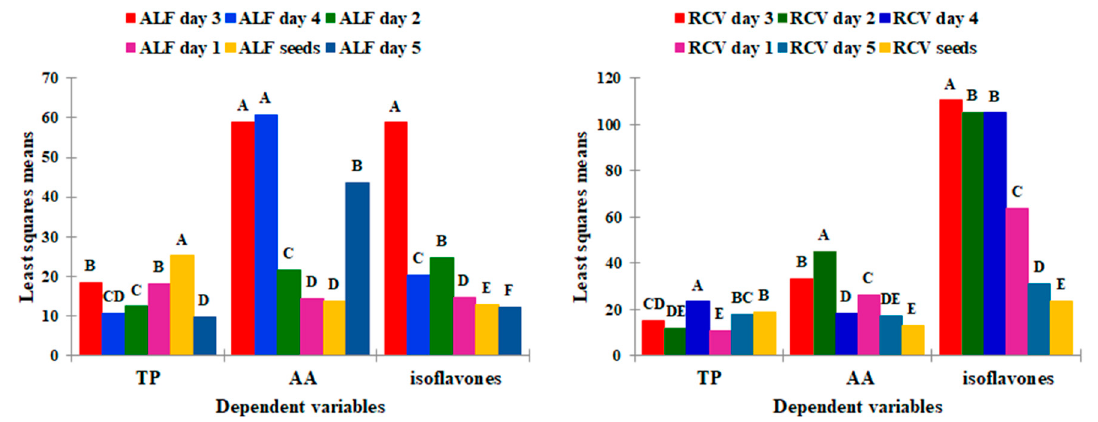
Figure 1. Variation of the total phenolic (TP) content (mg gallic acid eq/g DW), the anti-radical activity (AA) as scavenging capacity of DPPH• (%) and isoflavones content (µg/g DW) in ALF and RCV sprouts during germination (sprouts samples was coded as: day 1—first day of germination; day 2—second day of germination; day 3—third day of germination; day 4—fourth day of germination; day 5—fifth day of germination). Different uppercase letters corresponding to the bars denote significant differences according to Duncan test p ≤ 0.05.